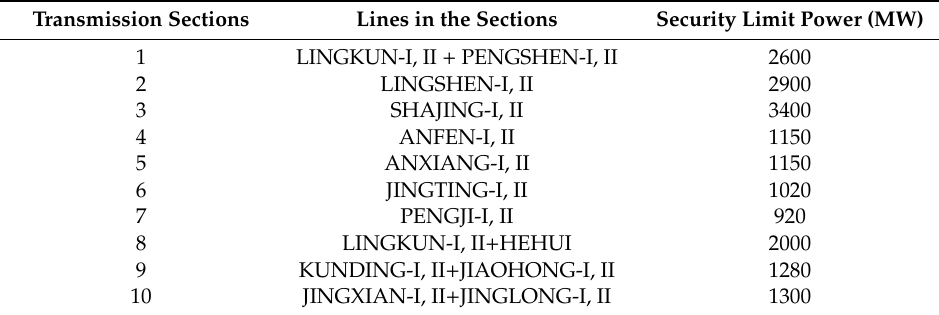
Table 10. Security limits of several key transmission sections.